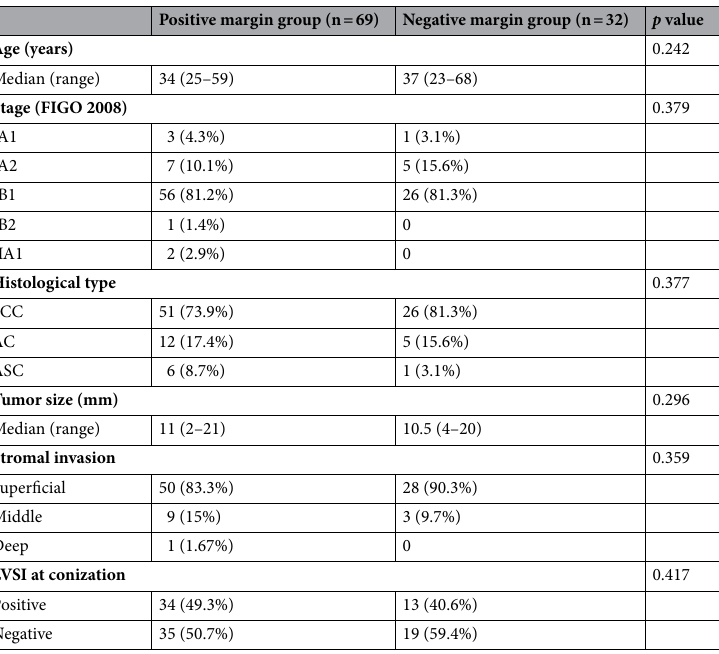
Table 1. Characteristics of 101 patients. SCC squamous cell carcinoma, AC adenocarcinoma, ASC adenosquamous carcinoma. p value of < 0.05 was considered statistically significant.